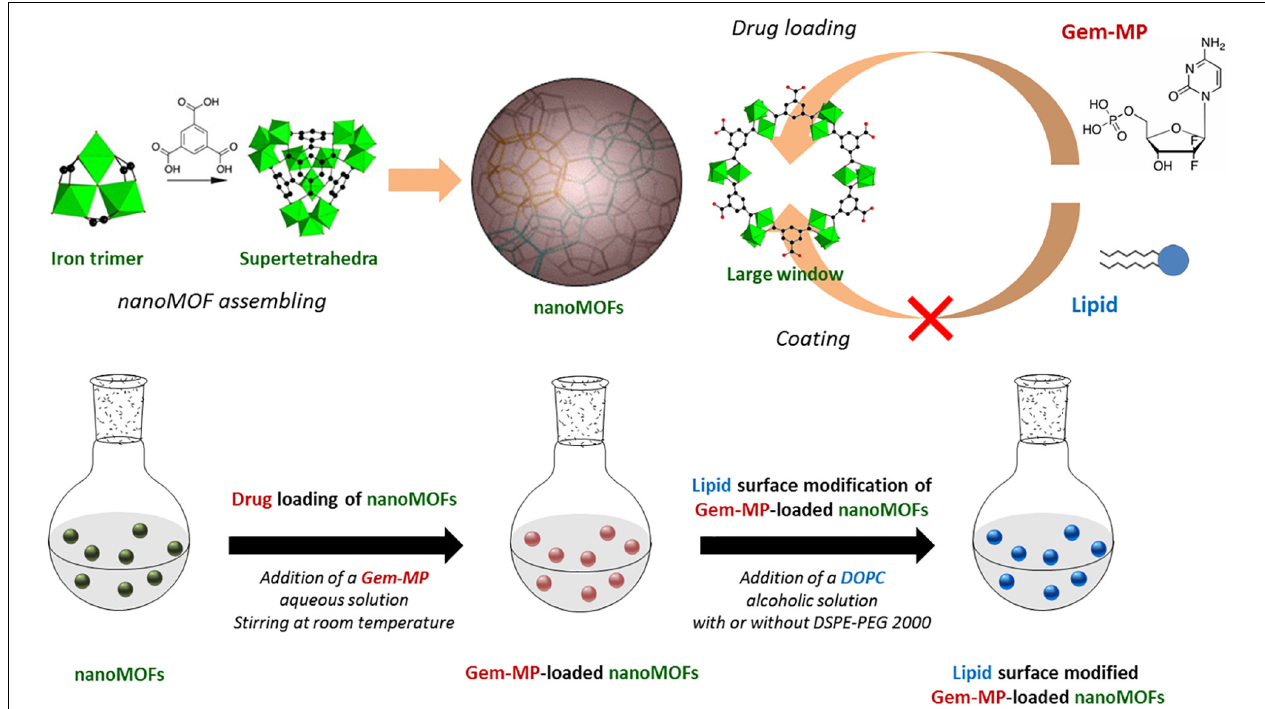
FIGURE 1 | Upper panel : Schematic representation of the MIL-100(Fe) nanoMOF assembly from iron trimers and trimesic acid. Gem-MP was loaded by impregnation from aqueous solutions, penetrating inside the nanoMOFs through their largest windows (approx. 9 Å in size). Lipid molecules (DOPC and DSPE-PEG 2000) with larger molecular dimensions than the large windows were used to coat the nanoMOFs. Lower panel : Preparation steps of lipid-coated nanoMOFs. First, Gem-MP was loaded, into the nanoMOFs followed by their coating with lipid shells and PEG-lipid conjugates.